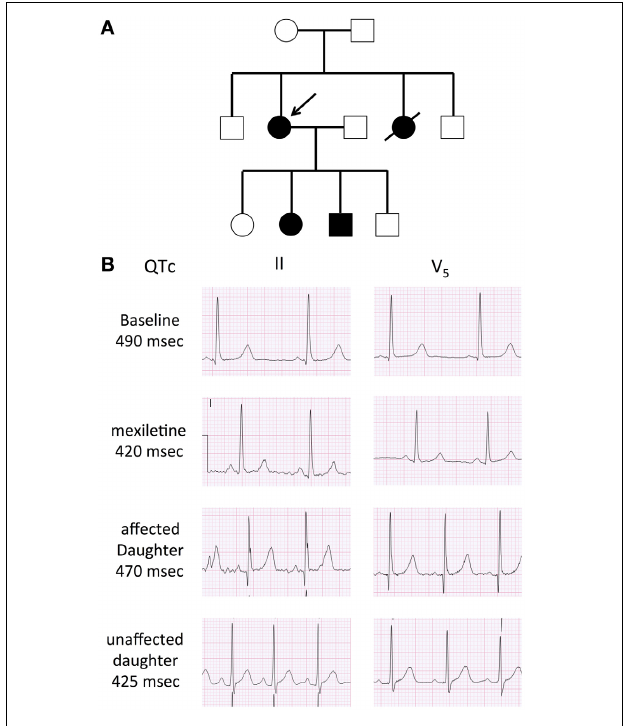
FIGURE 1 | Family pedigree and 12-lead ECG of the proband. (A) Family pedigree. Subjects II-2 and III-2 and III-3 with the LQT3 phenotype (black circle and square), the arrow indicates the proband. (B) Twelve-lead ECG. Baseline ECG in the proband, demonstrating a long isoelectric ST segment, followed by a deferred T was with normal morphology. The second ECG represents a repeat ECG after 2 doses of 200mg of mexilitine. The ECGs of her affected and unaffected daughter are also presented. Voltage scale: 0.5mV/large square, time scale: 0.2s/large square.